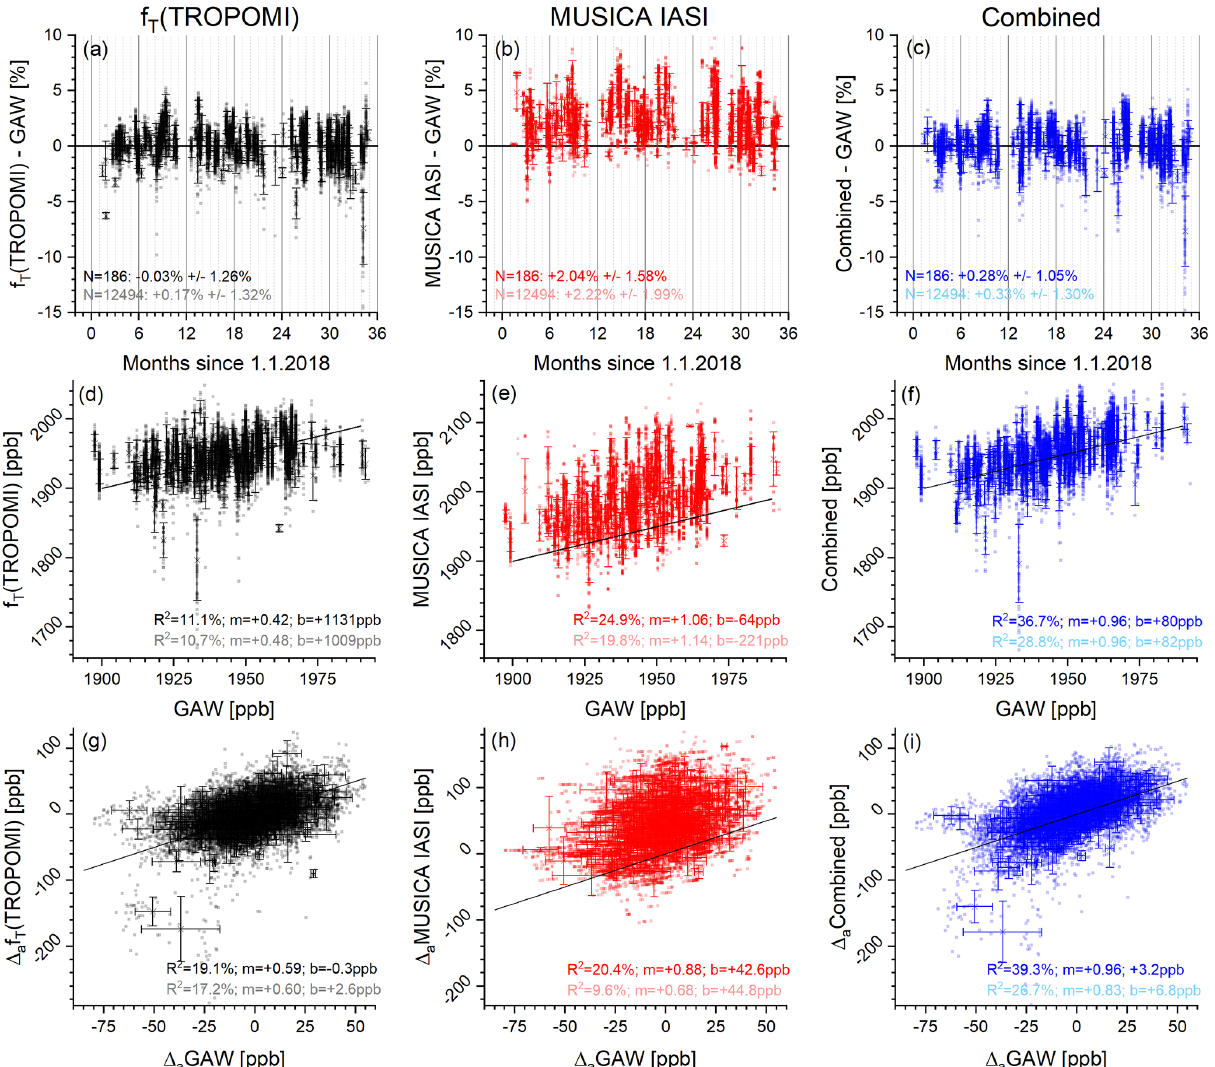
Figure 13. Comparison of GAW measurements made at Jungfraujoch and Schauinsland with the TROPOMI tropospheric CH 4 proxy prod- uct according to Eq. (8) and the IASI and the combined tropospheric CH 4 products. Data for all individual coincidences are shown in the background as squares, and daily averages are depicted as crosses with error bars representing the daily 1 σ standard deviations (daily means are only calculated if there are at least three observations per day). (a–c) Time series of differences. (d–f) Correlation between GAW and satellite data (the black line is the one-to-one diagonal). (g–i) Correlations between the difference of GAW and a priori data ( (cid:49) a GAW = troXCH 4 ( GAW ) − troXCH 4 ( a priori ) ) and the a priori free satellite data ( (cid:49) a Satellite = troXCH 4 ( Satellite ) − troXCH 4 ( a priori ) ). The in- serted text reports median and scatter (hIPR68.2; a–c ) and the coefficients of determination, the slope, and the intercept of the robust linear regression model ( R 2 , m , and b ; d–i ). Dark and pale coloured fonts represent the values for the daily mean data and for data from all individual collocations,